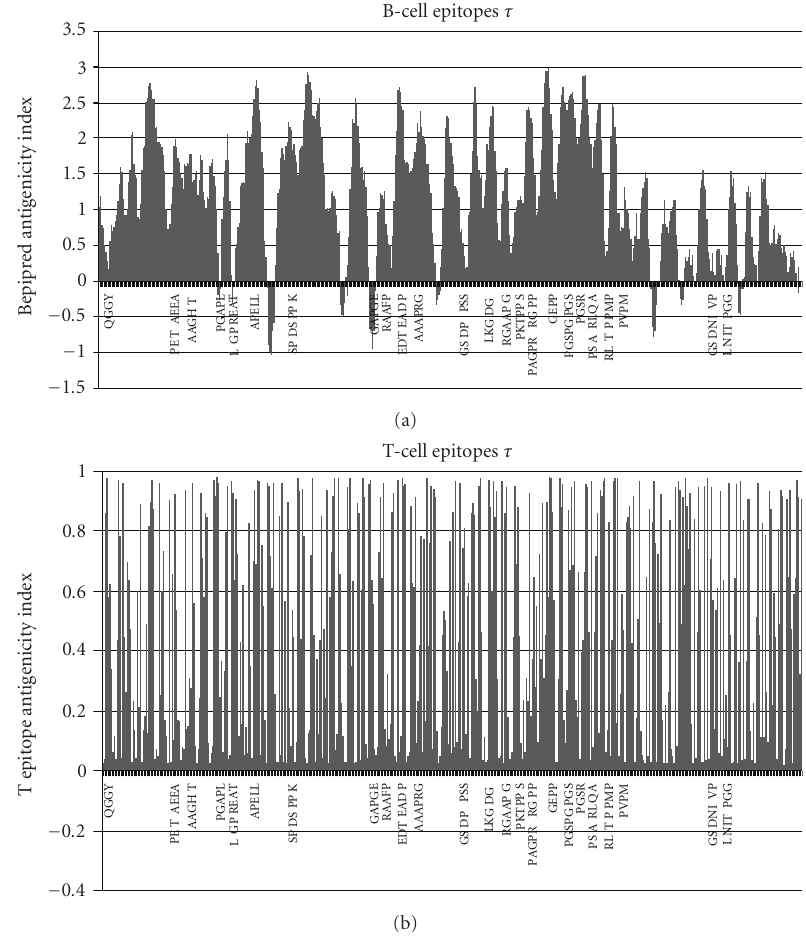
Figure 3: The B cell and T cell immunogenicity profile for the tau protein. The sequences of herpes simplex viral proteins that align with tau are shown. Space: non-identical amino acid; +: conserved amino acid with similar physicochemical properties. to form stable immune complexes and likely represent